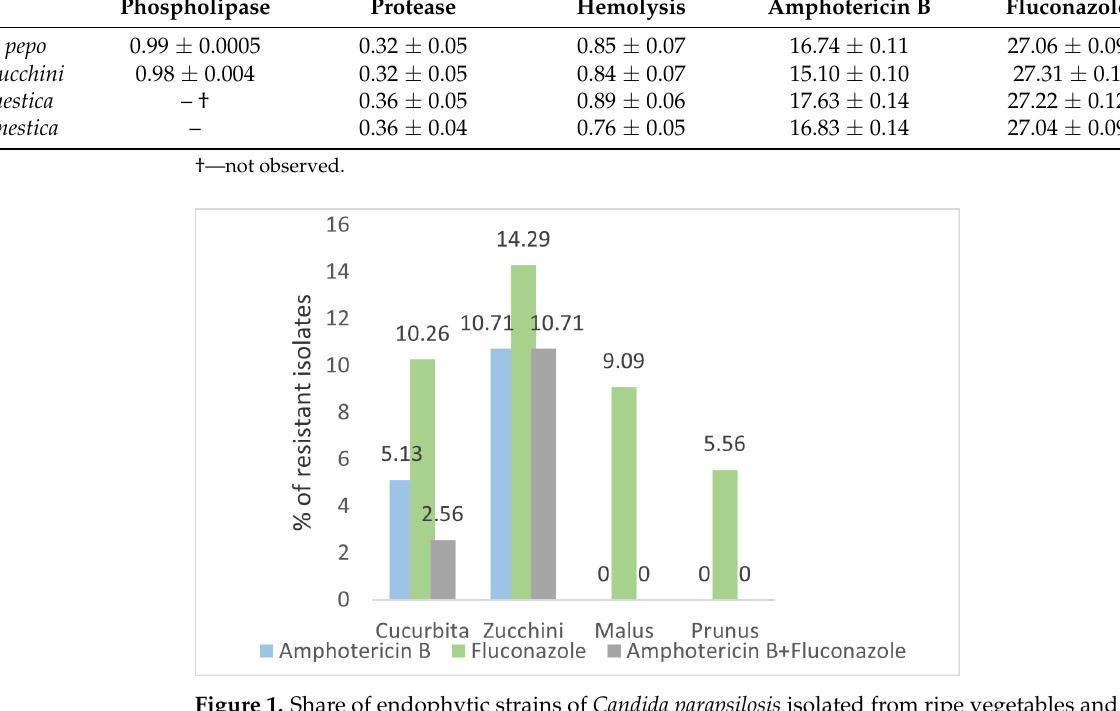
Figure 1. Share of endophytic strains of Candida parapsilosis isolated from ripe vegetables and fruits resistant to Amphotericin B, Fluconazole, and both antifungal